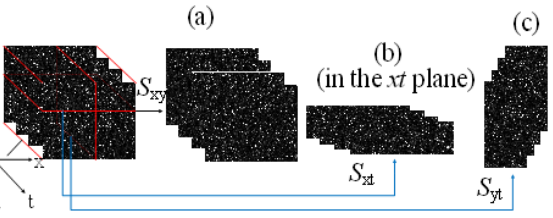
Figure 6. Schematic diagram of LBP-TOP feature extraction. (a) an image in the XY plane, (b) an image in the XT plane, giving a visual impression of a row over time, and (c) the movement of a column in time space